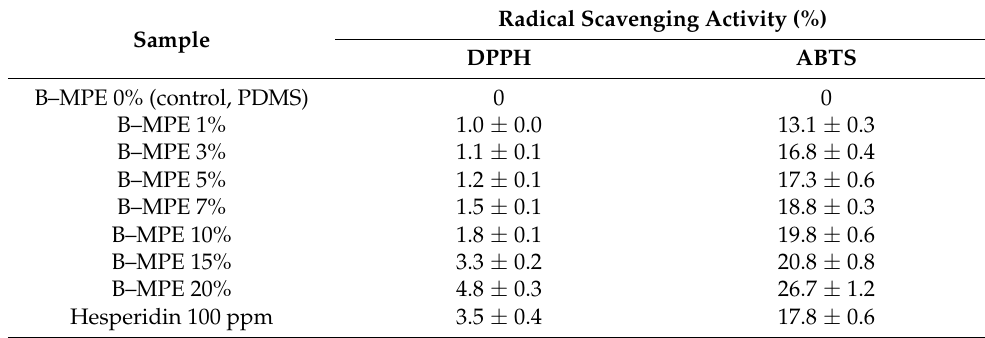
Table 2. Radical scavenging activity of the fabricated